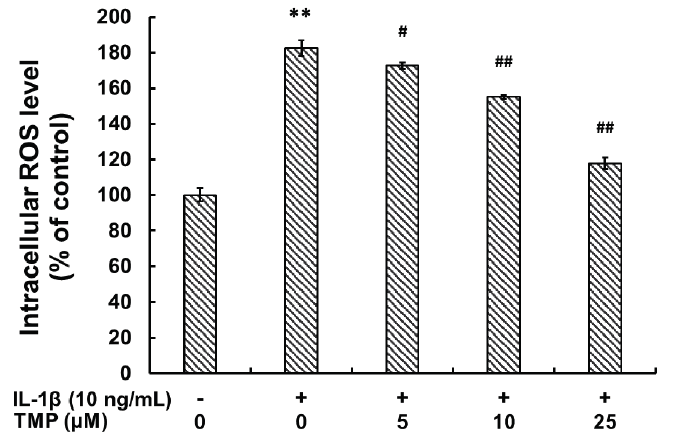
Figure 2. Effect of TMP on IL-1 β -induced ROS generation in TR-iBRB2 cells. After treatment of indicated drugs, the intracellular ROS generation in TR-iBRB2 cells was determined by flow cytometry using DCFH-DA staining. All data were expressed as mean ± SD of three experiments and each experiment included triplicate repeats. ** p < 0.01 vs. control group; # p < 0.05; ## p < 0.01 vs. IL-1 β -treated